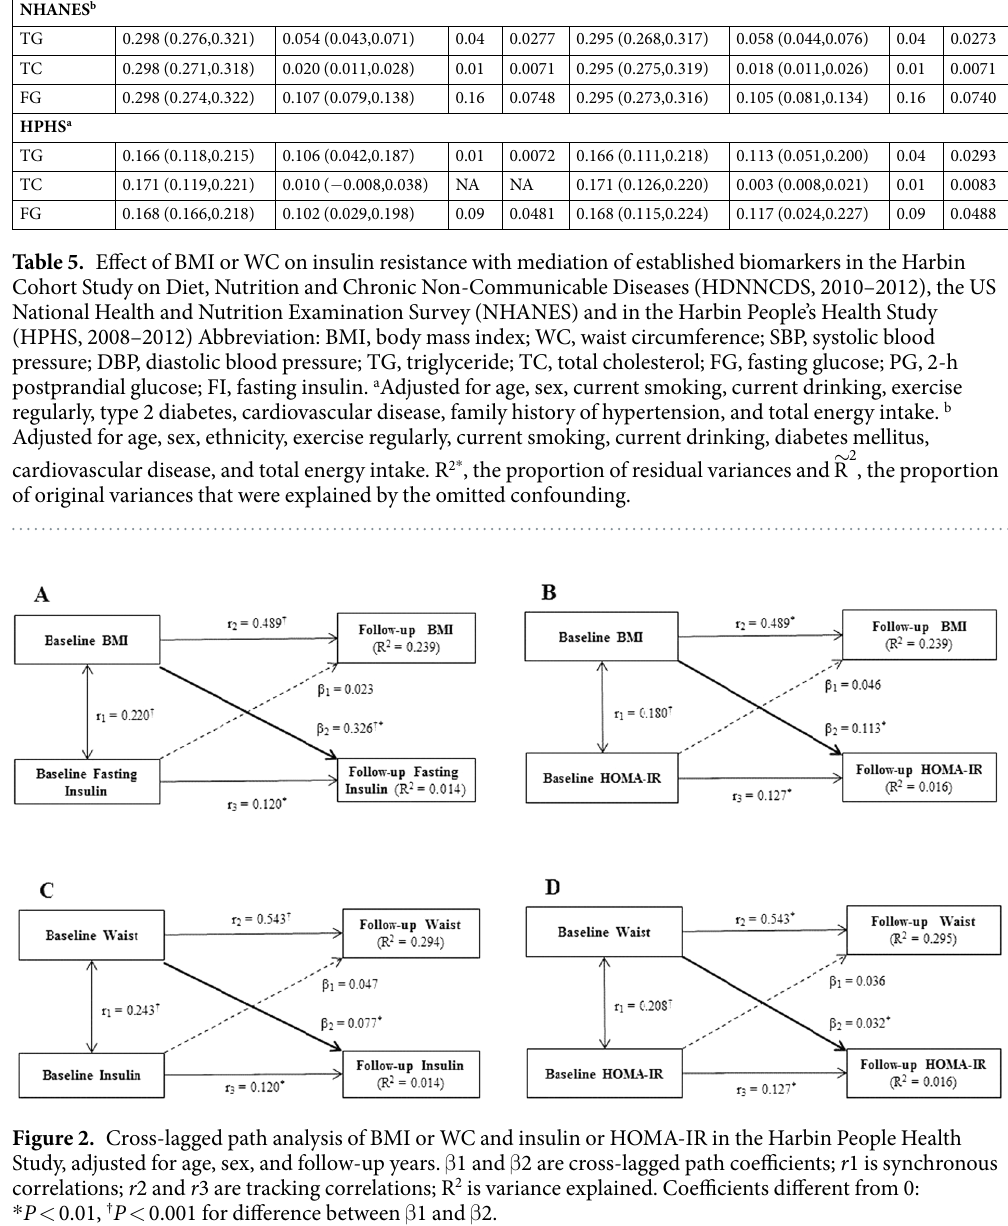
The HDNNCDS and the HPHS were approved by the institutional ethics review board of the Harbin Medical University and were conducted in accordance with the guidelines of the Declaration of Helsinki. Written informed consent was provided by all participants. NHANES is a cross-sectional, biannual, representative health survey of the United States population 35 . We used data from four surveys (2005–2006, 2007–2008, 2009–2010, and 2011–2012). 24-hour food recall ques- tionnaire were administered using the United States Department of Agriculture (USDA) and US Department of Health and Human Services (DHHS) food recall questionnaire. Self-reported data were also collected for diabetes mellitus, coronary disease status, current drinking, and current smoking. Height, weight, and 3 to 4 seated systolic